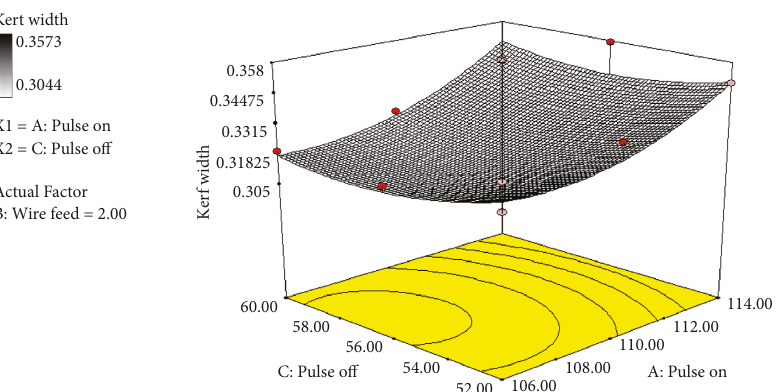
Figure 7: Effect on the PT